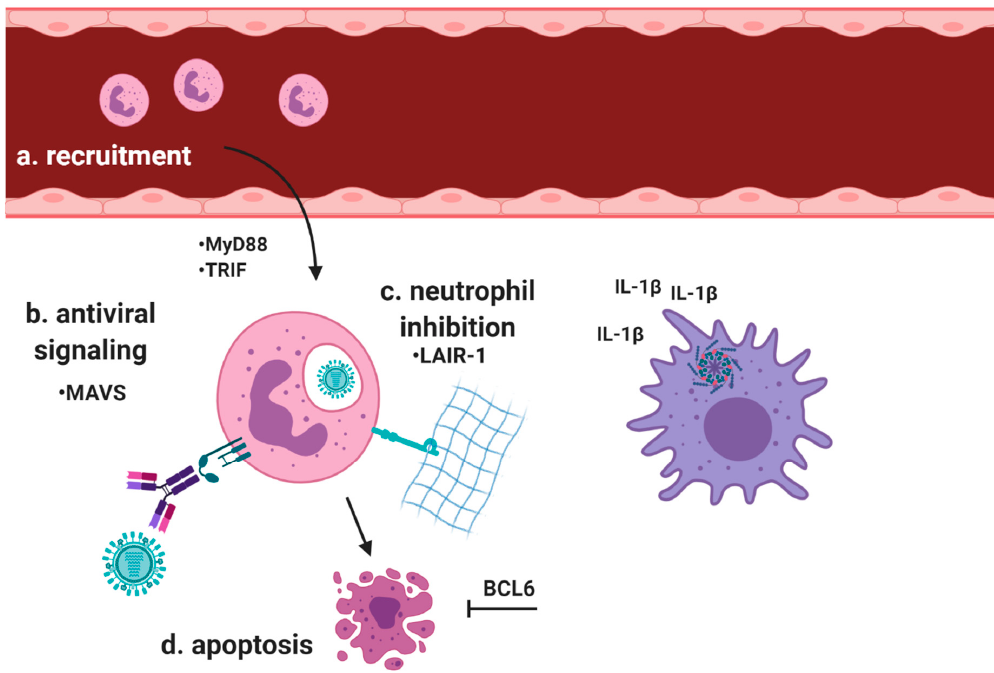
Figure 2. Neutrophil responses to viral infection. Neutrophils have an important role in